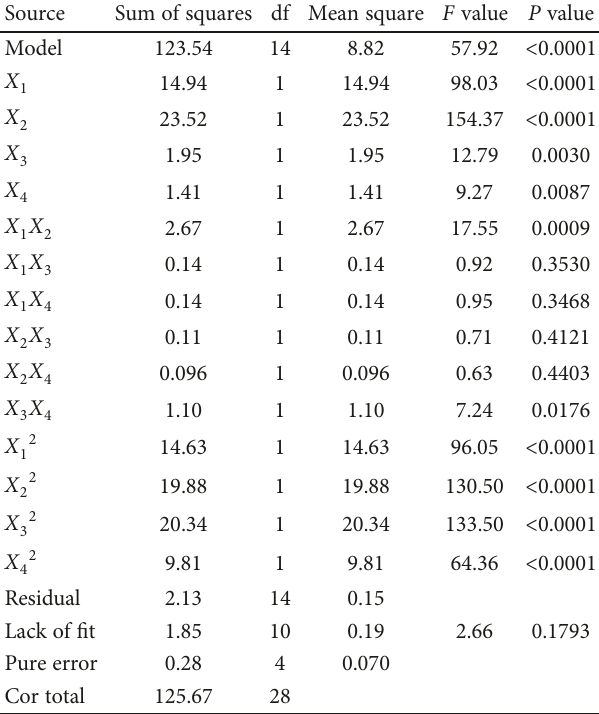
Table 3: Experimental design and the results of the Box-Behnken design for the optimization process.